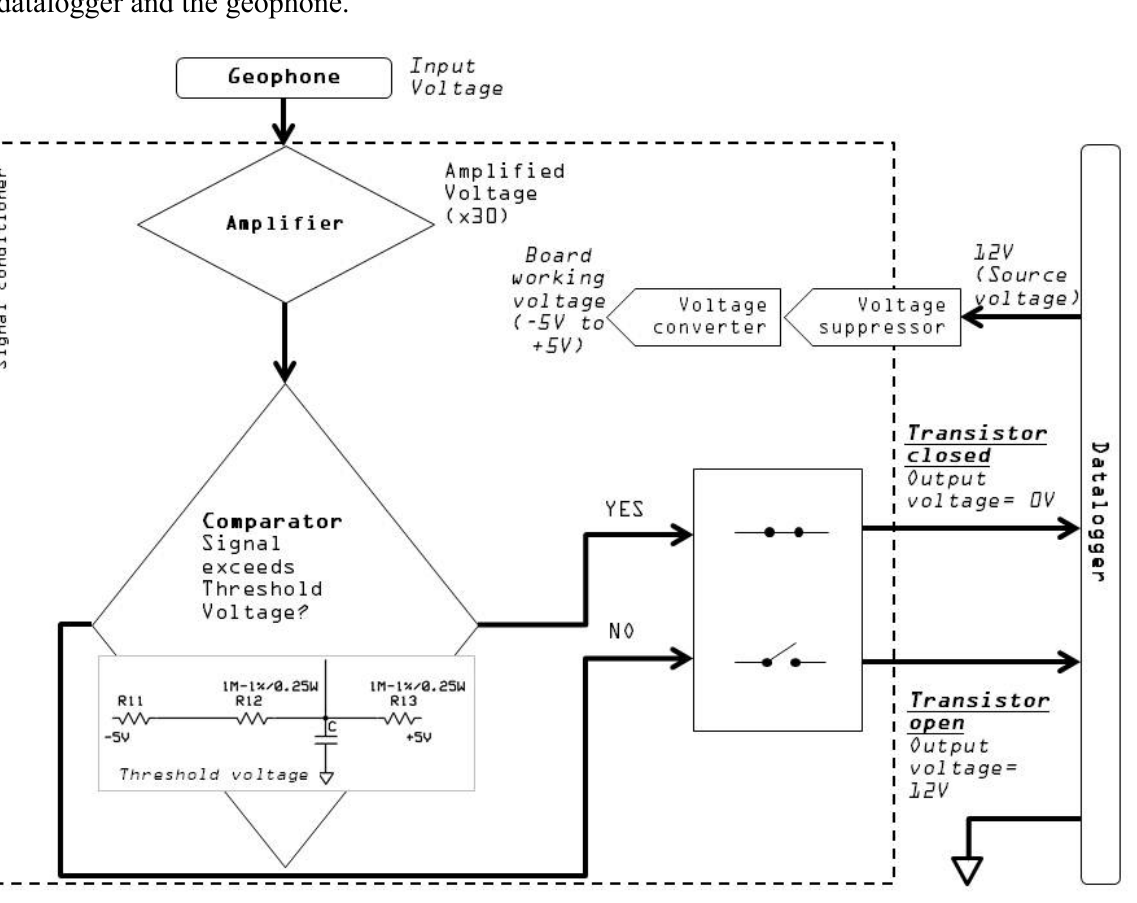
Figure 4. Simplified diagram of the signal conditioner and its interaction with the datalogger and the